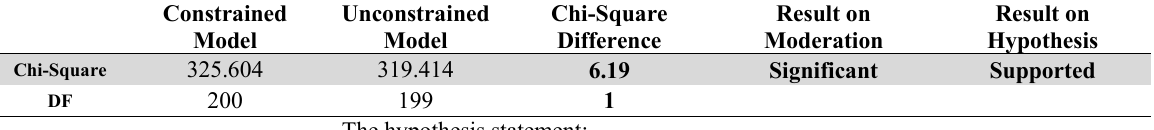
Constrained Model